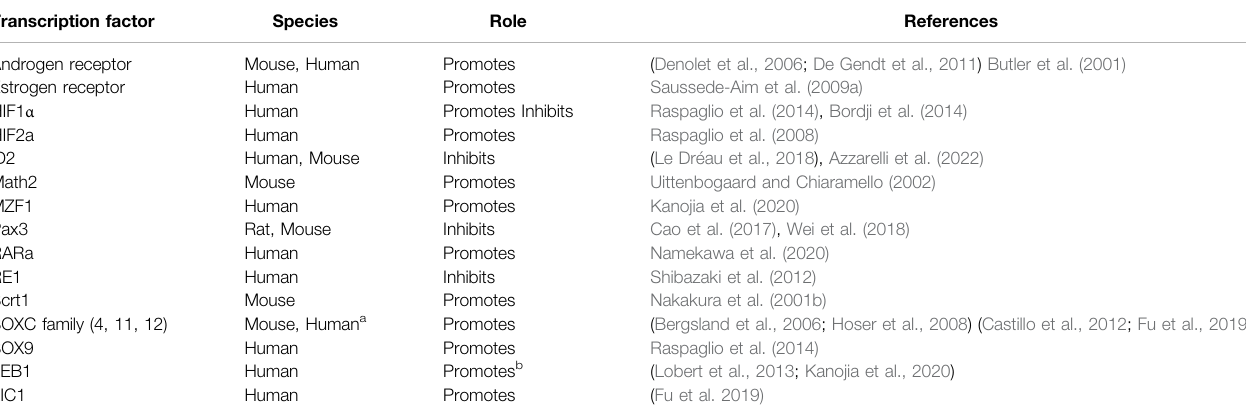
TABLE 4 | Transcription factors with known impact on TUBB3